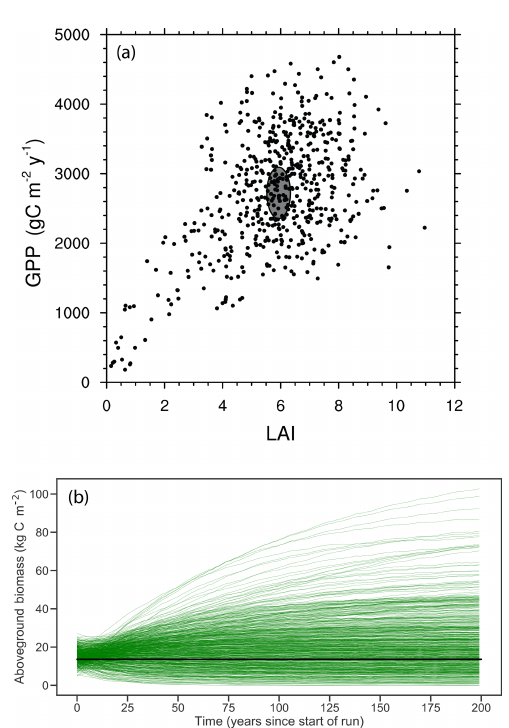
Figure 5. Joint distribution of modeled GPP and LAI (a) and modeled time series of biomass trajectories (b) for a 576-member ensemble of site-scale FATES simulations, where each ensemble member, represented here as an individual dot, has a single PFT de- fined as a random draw from the 12-trait covariance matrix shown in Fig. 3. Site-level observations of LAI and GPP (mean ± 1SD) are shown in (a) as a grey ellipse, and observed mean biomass is shown in (b) as black